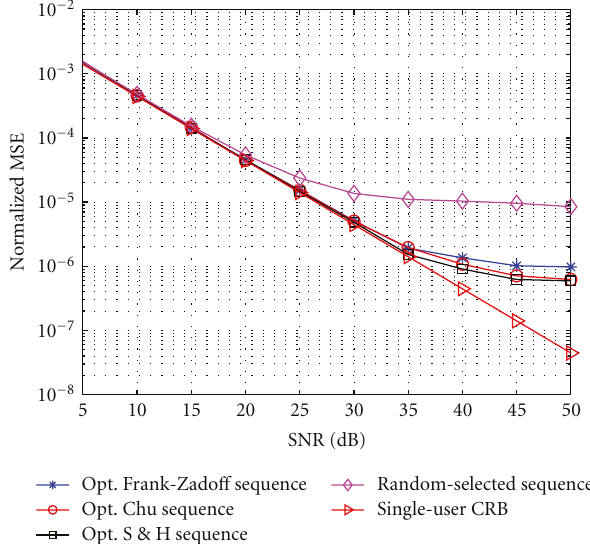
Figure 5: Comparison of CFO estimation using di ff erent N = 36 CAZAC sequences for L = 18 channel for exponential power delay profile.